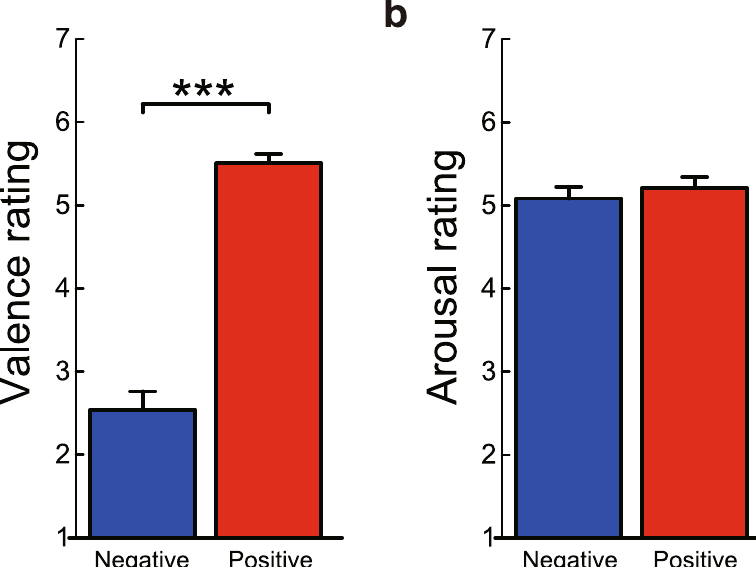
Figure 3. Subjective ratings of auditory stimuli. ( a ) Perceived emotional valence of auditory stimuli. Participants rated positive vocalisations to be more positive than negative vocalisations. ( b ) Perceived emotional arousal of auditory stimuli. There was no difference in arousal rating between negative and positive vocalisations, confirming that we could effectively manipulate emotional valence of action outcomes while controlling for emotional arousal. Data are represented as mean ± SEM. *** P <